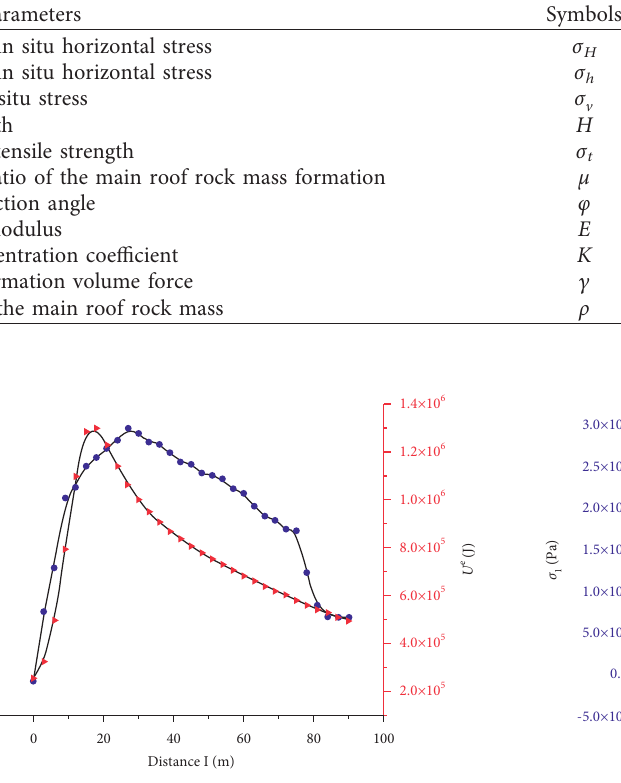
Figure 12: Relationship between the maximum principal stress σ elastic strain energy U e and I .